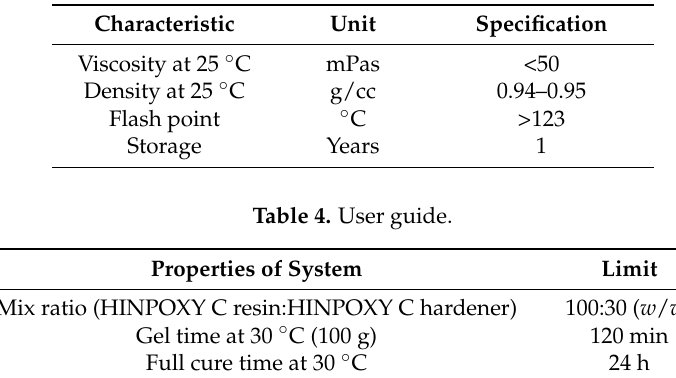
Table 3. Properties of HINPOXY C hardner.